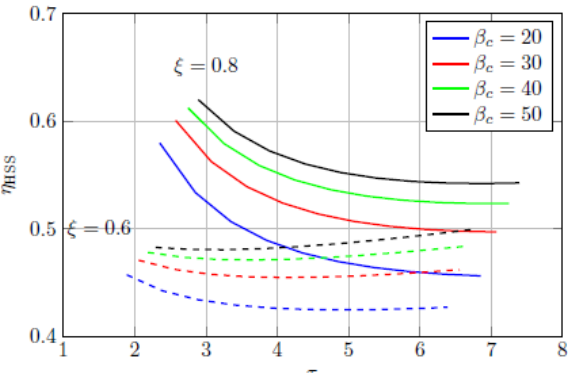
Figure 2. Efficiency of the hybrid storage system (HSS) as a function of τ for different values of β c from 20 to 40. The plot refers to a system with ξ = 0.8 ( left ) and ξ = 0.6 ( right ), β e = 0.9 * β c , η el = 0.80, η t = 0.9, η c = 0.9, and η cc = 0.98. For the selected range of β c , 0.42 < ξ < 1.